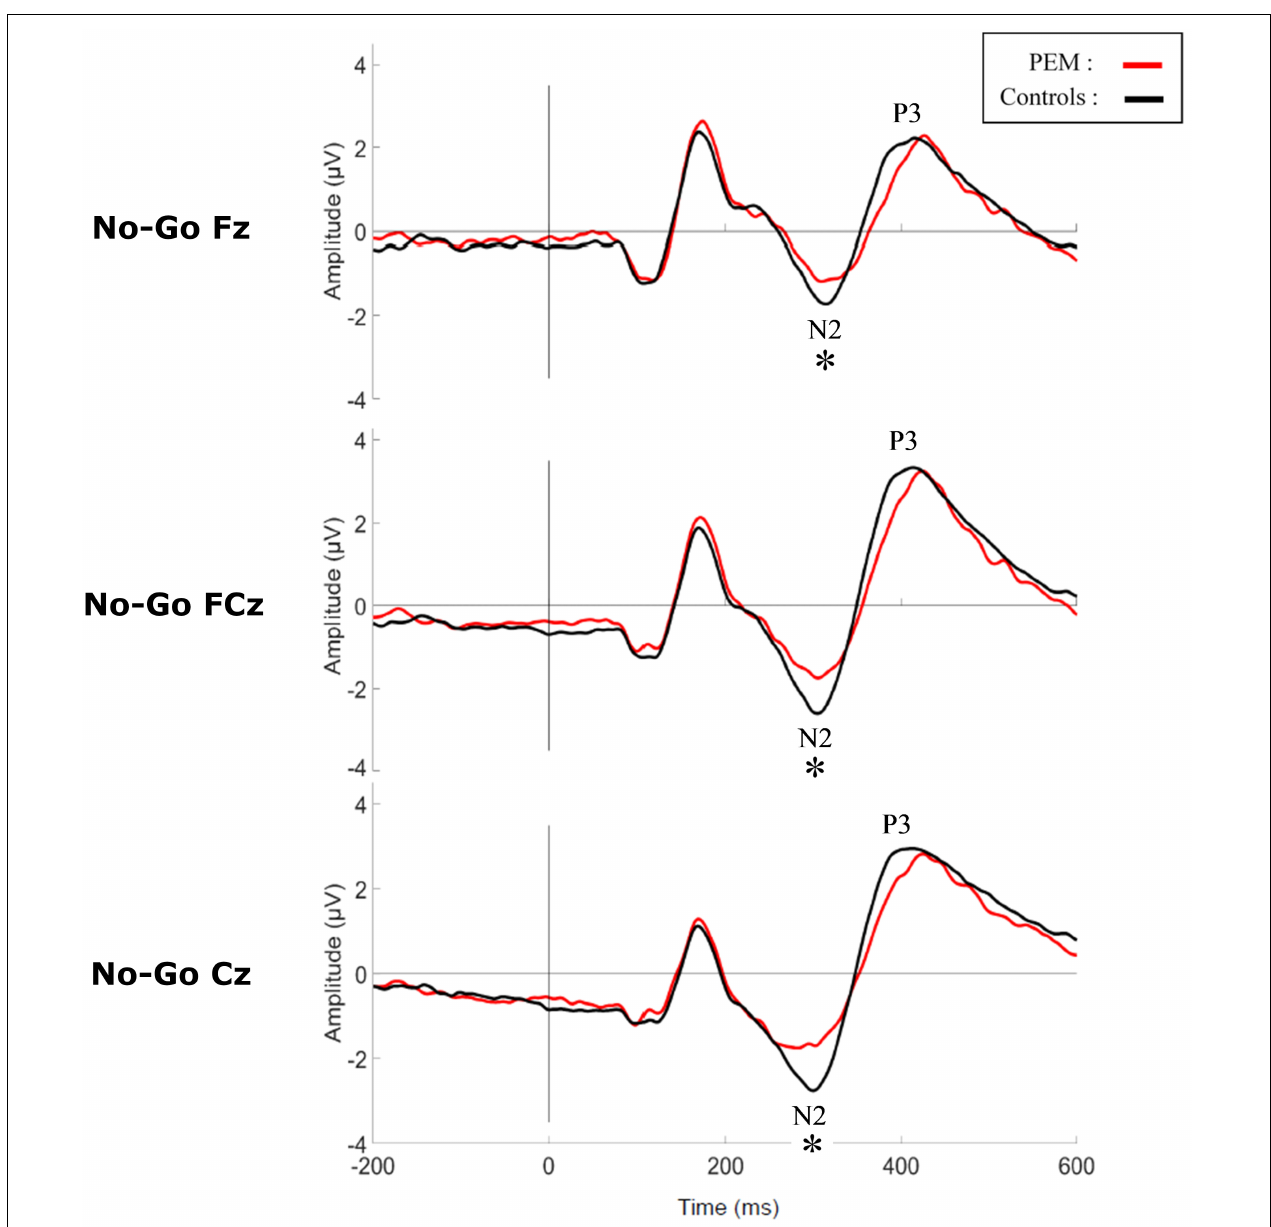
FIGURE 3 | Grand average waveform of the N2 and P3 components during No-Go condition for each group. ∗ p <